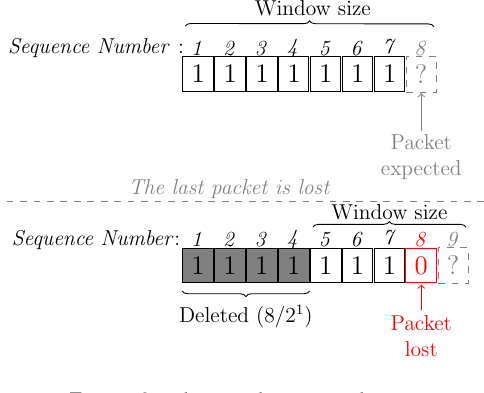
Figure 2. The windowsize reduction The timer is scheduled to trigger a transmission of a probe packet every seconds. To avoid a synchronization among nodes, transmissions are delayed according to a random variable fixed at [0 ; 210] ms . We also consider the signal propagation delay as insignificant, for the reason that the celerity of an electromagnetic wave in the air is at 3 (cid:2) 10 8 m:s (cid:0) 1 . Therefore, a delayed reception cannot exceed one second. Window Size Growing Algorithm. To ensure a suitable link quality estimation, it is required to adjust the estimation to the link stability. The suggested algorithm attempts to adjust the window by keeping or increasing its size. Indeed, once a packet is received, the algorithm determines if the window is increased or slid. To this end, a threshold T h is set as the window size, once lower than T h , the widow size is incremented by one for each new packet received. Indeed, the algorithm tries to recover the last window size when a disruption